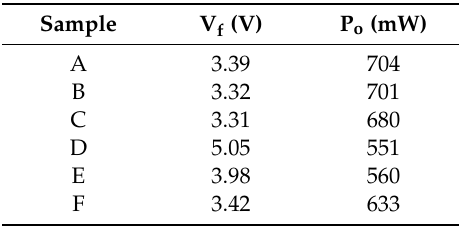
Table 2. Forward voltage (V f ) and output power (P o ) at injection current of 350 mA for all samples with a chip size of 533 × 1092 µ m 2